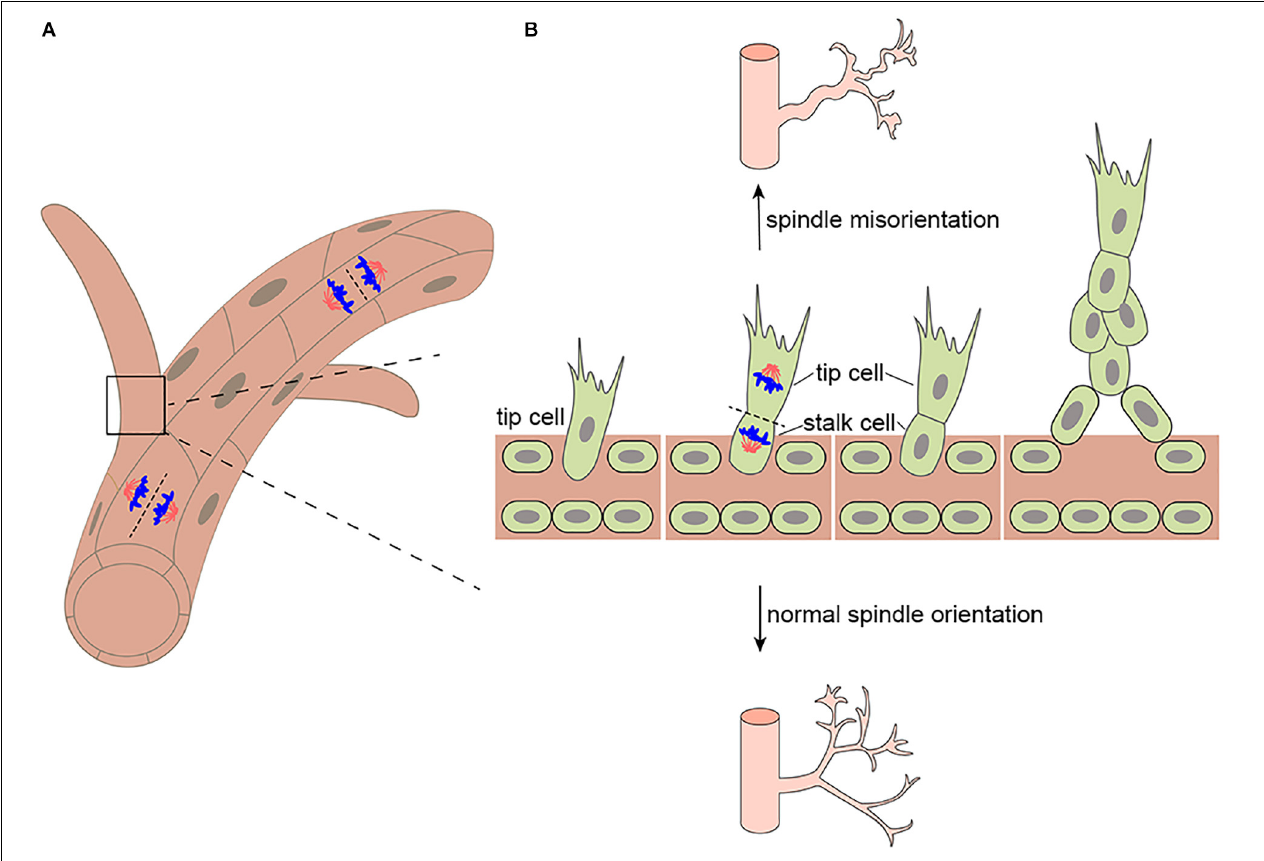
FIGURE 1 | Mitotic spindle orientation in endothelial cell affects vessel morphogenesis. (A) Endothelial divisions oriented perpendicular to the vessel long axis (on top) would effectively lengthen the vessel, whereas divisions oriented parallel to the vessel long axis (on bottom) would effectively increase the vessel diameter. (B) During branching morphogenesis, highly motile endothelial tip cells sprout from parental vessels and lead stalk cells. Upon tip cell division, the mitotic spindle is displaced to the proximal pole of the cell before anaphase. This introduces cell size asymmetry and generates daughter cells with distinct VEGF signaling levels. In addition, aberrant mitotic spindle orientation changes endothelial cell cleavage plane and further increasing vessel tortuosity and